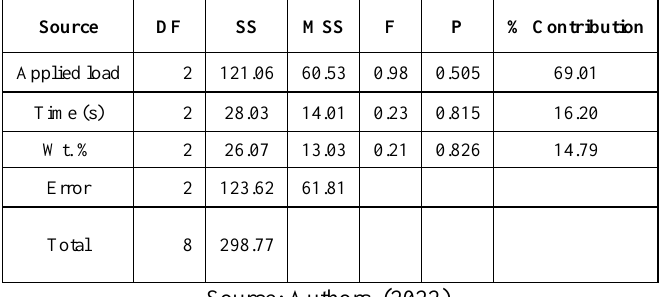
Table 8: Analysis variance results for low speed.